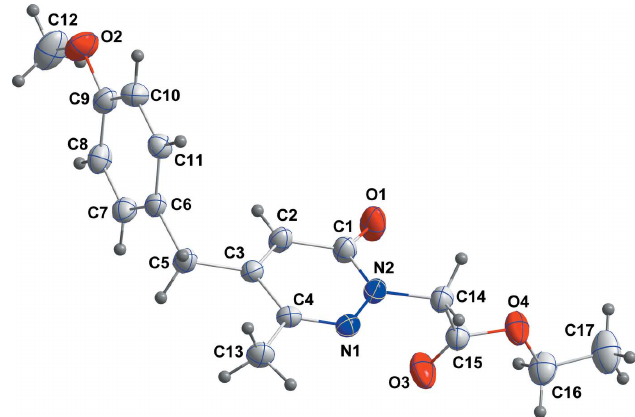
Figure 1 The title molecule with labelling scheme and 30% probability ellipsoids. Only the major component of the disordered ethyl group is